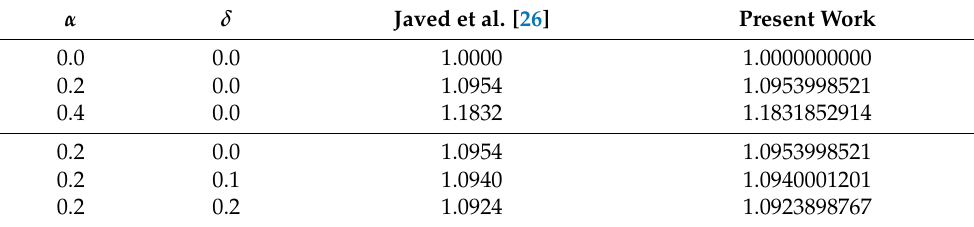
Table 1. Comparison of Cf x Re 1 2 with the results of Javed et al. [26] when γ = 0. α δ Javed et al. [26] Present Work